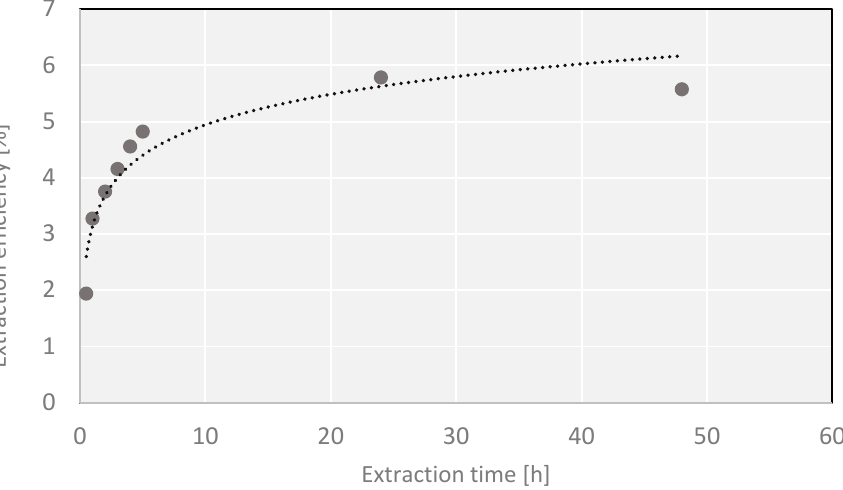
Figure 1. Dependence of the yield on the extraction time in a Soxhlet apparatus.